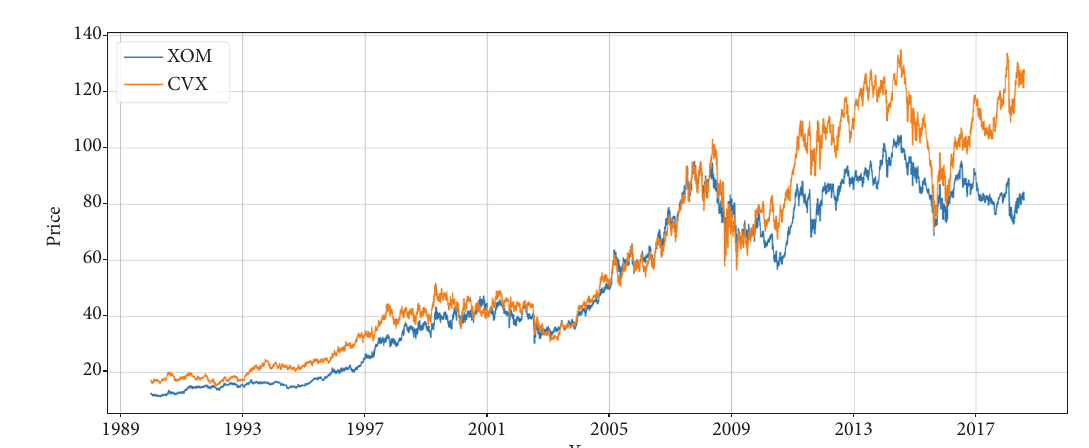
Figure 2: Cointegrated stock price